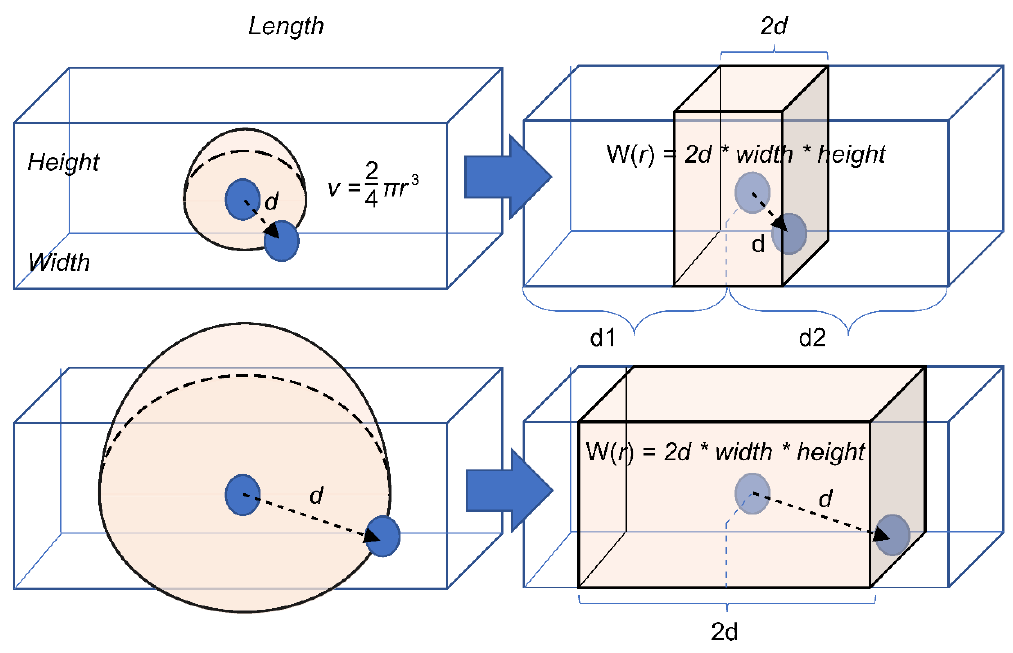
Figure 2. Simplified model for volume estimation of the space between two individuals in a vehicle.